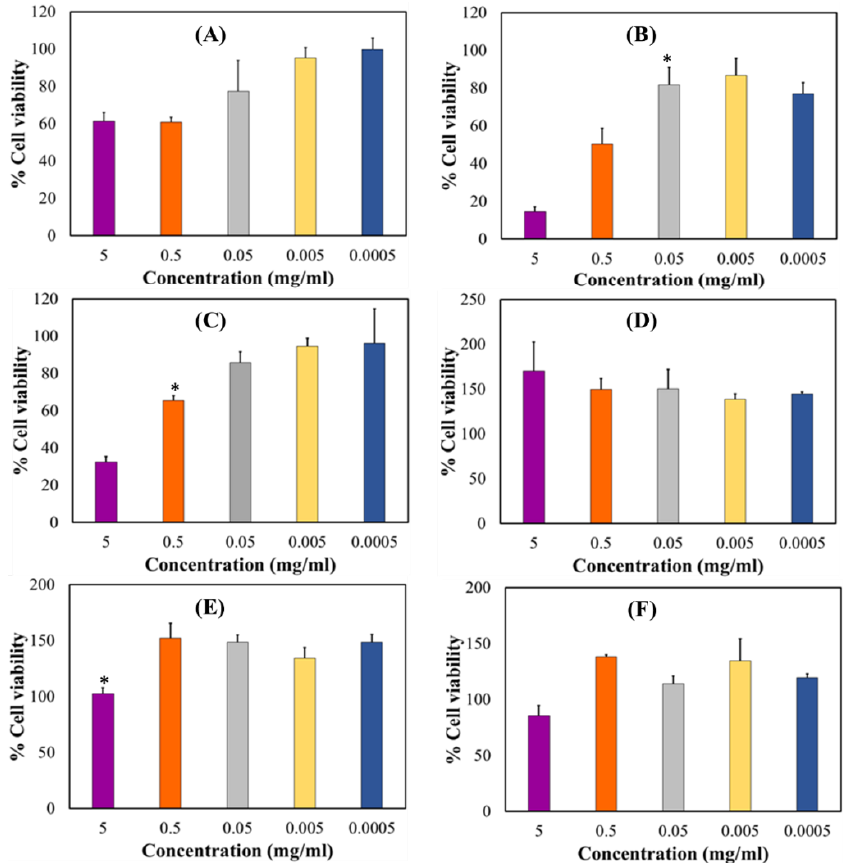
Figure 9. HepG2 cell biocompatibility levels measured by MTT analysis ( A ) drug loaded formulation, ( B ) placebo and ( C ) pyrazinamide and, neutral red assay ( D ) drug loaded formulation, ( E ) placebo and ( F ) pyrazinamide. Results represent mean ± SEM and statistical significance ( p < 0.05) indicated with an asterisk (*) .